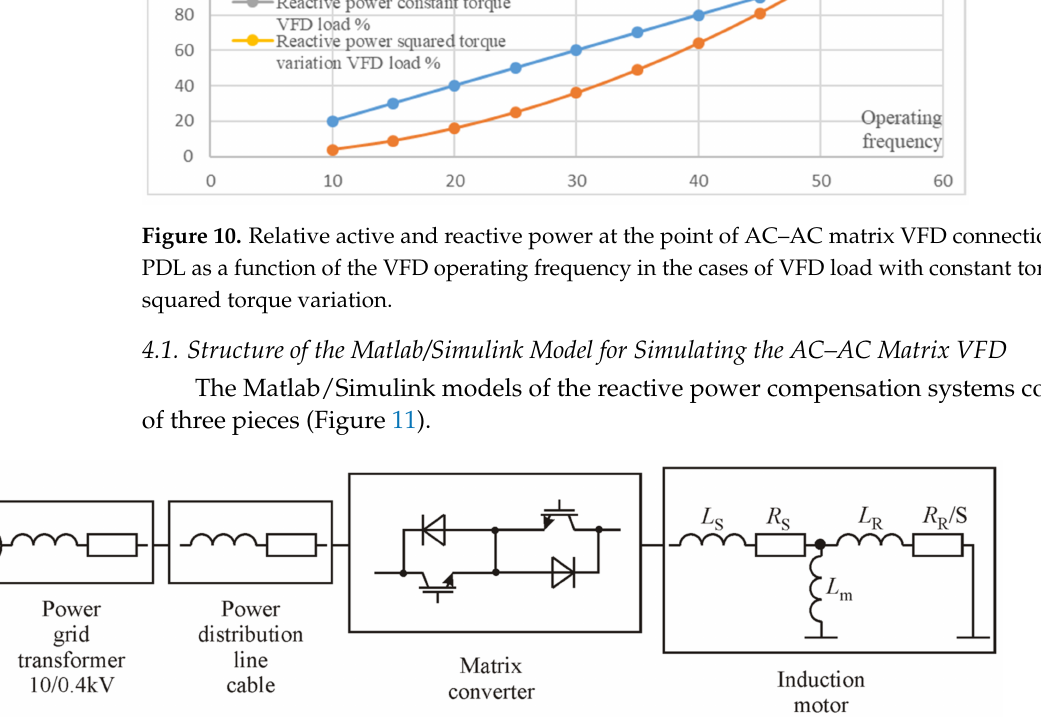
Figure 11. Structure of the AC–AC matrix VFD Matlab/Simulink